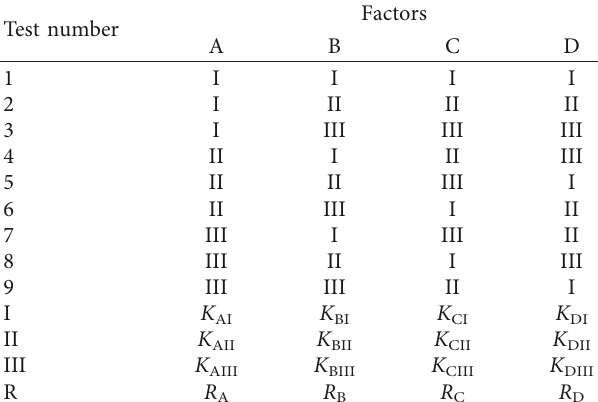
Table 2: Orthogonal table L